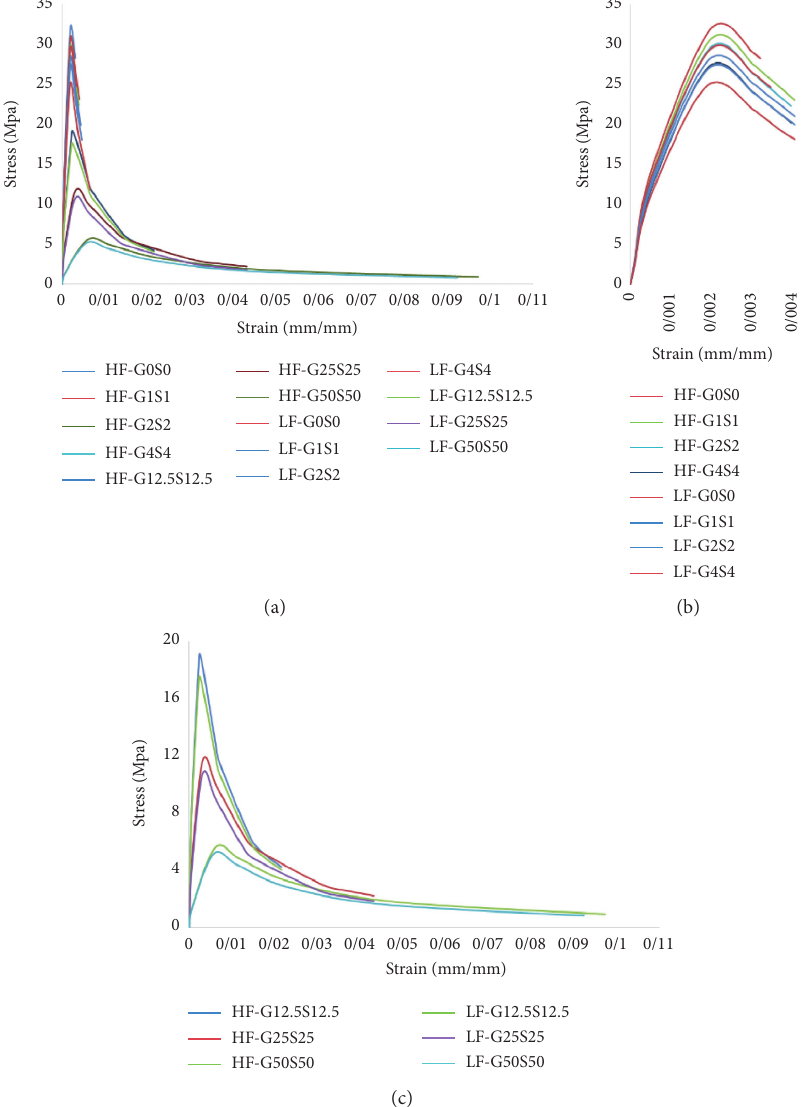
Figure 8: Stress-strain curve of HF&LF specimens at 28 days. (a) Stress-strain diagrams of all HF&LF specimens at 28 days. (b) Stress-strain diagrams of HF&LF specimens contain a low content of silicone rubber at 28 days. (c) Stress-strain diagrams of HF&LF specimens contain a high content of silicone rubber at 28 days.